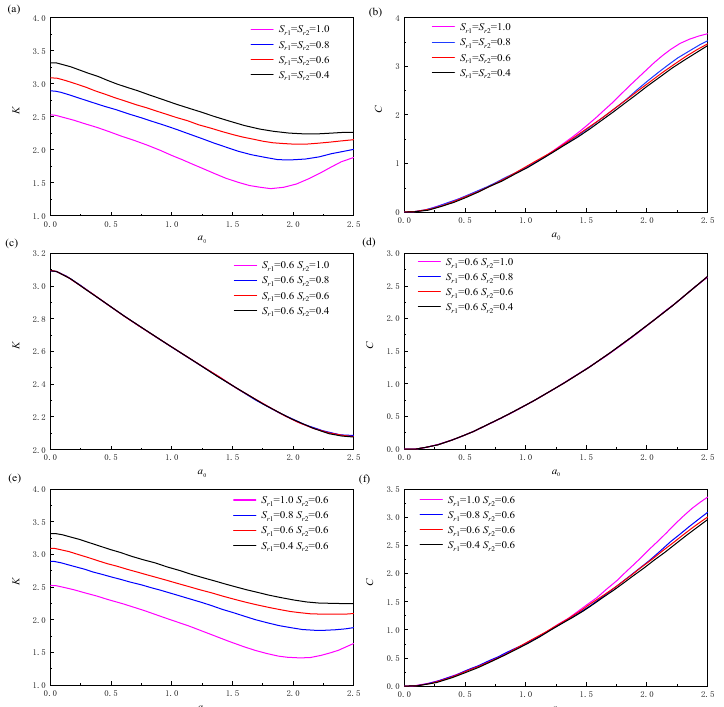
Figure 18. Influence of the saturation of soil on the dynamic torsional impedance of pile (reproduced from Ma et al. (2022) [188]): ( a ) dynamic stiffness with the variation of both the outer and inner soil’s saturations; ( b ) dynamic damping with the variation of both the outer and inner soil’s saturations; ( c ) dynamic stiffness with the variation of the inner soil’s saturations; ( d ) dynamic stiffness with the variation of the inner soil’s saturations; ( e ) dynamic stiffness with the variation of the outer soil’s saturations; ( f ) dynamic damping with the variation of the outer soil’s saturations. Due to the fact that the shear wave velocity is almost half of the compressive wave velocity, some scholars pointed out that the utilization of the shear wave can effectively reduce the detection blind zone of the compressive wave if adopting the shear wave for